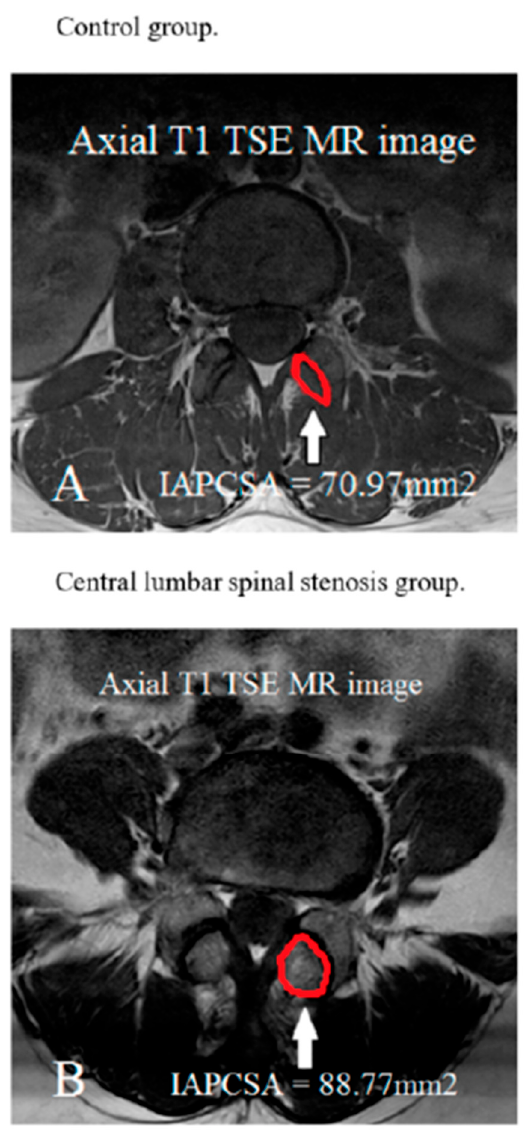
Figure 1. Measurement of the IAPCSA in T1-weighted axial turbo spin echo MRI (TSE MR) at the highest stenotic